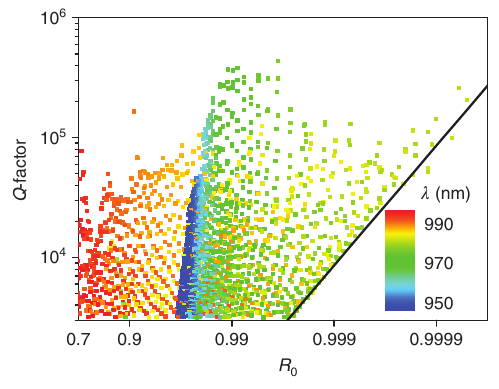
Figure 10: Q -factor of a D-D microcavity versus the power reflectance ( R ) of the top DBR (black line) and Q -factor for an M-M 0 microcavity versus the power reflectance ( R at various resonant wavelengths. The color points represent the resonant wavelengths of the M-M